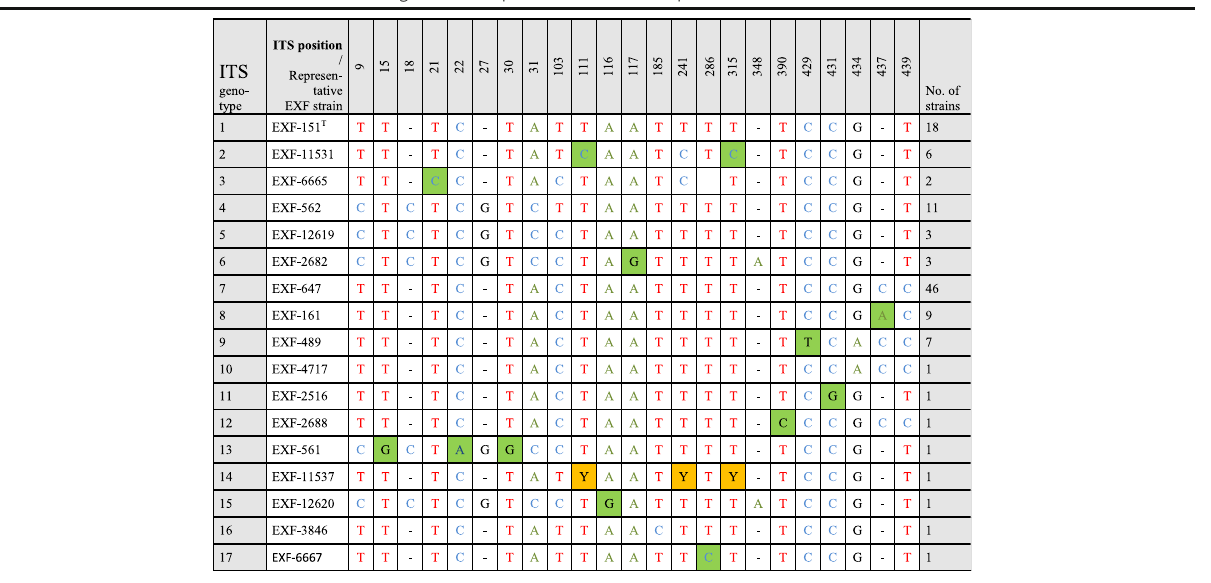
Table 3 Variable sites in Hortaea werneckii alignment of partial ITS rDNA sequences